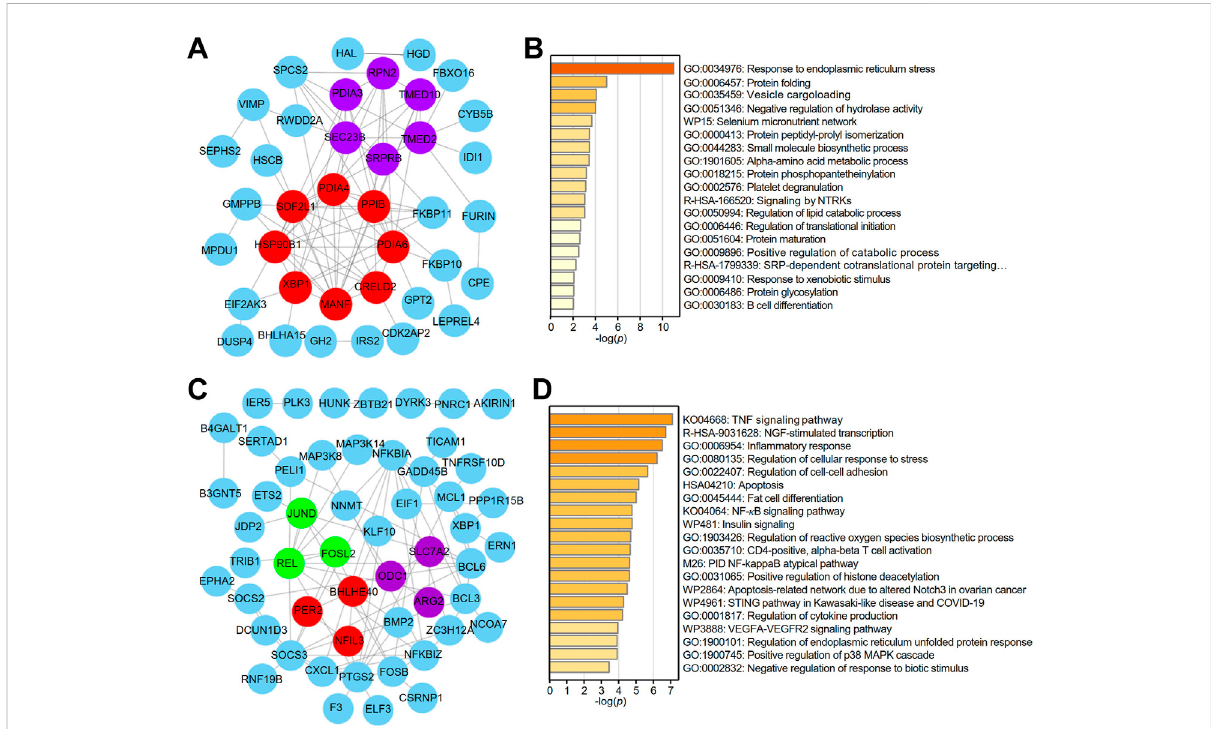
FIGURE 3 Identi fi cation of potential functions of XBP1 in LUAD. (A) The PPI network of top 100 genes with similar expression pro fi le of XBP1 in LUAD. STRING and Cytoscape were used to analyze the PPI network and tow (red and purple) core modules were identi fi ed. (B) Metascape pathway enrichmentanalysisoftop100geneswithsimilarexpression pro fi leofXBP1inLUAD,colored by p -values. (C) ThePPInetwork oftop100geneswith similar expression pro fi le of XBP1 in adjacent peritumor normal tissues. Three (red, purple and green) core modules were identi fi ed by STRING andCytoscape. (D) Top20clustersfromMetascapepathwayenrichmentanalysisoftop100geneswithsimilarexpressionpro fi leofXBP1inadjacent peritumor normal tissues, colored by p